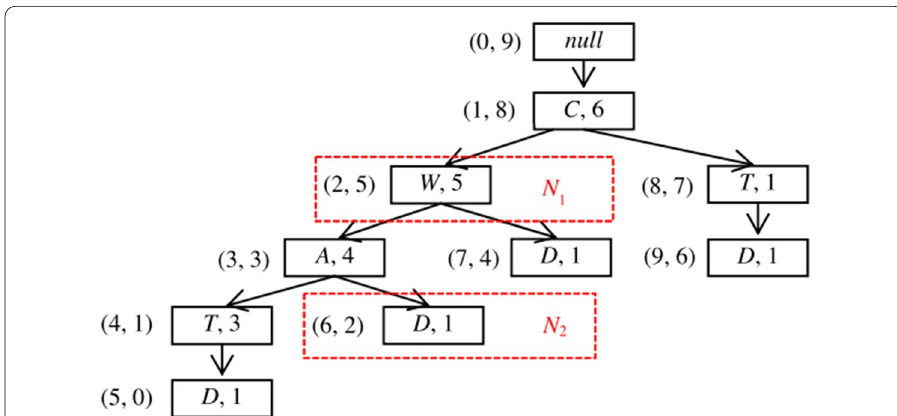
Fig. 5 The final PPC tree created from the DB example with minSup